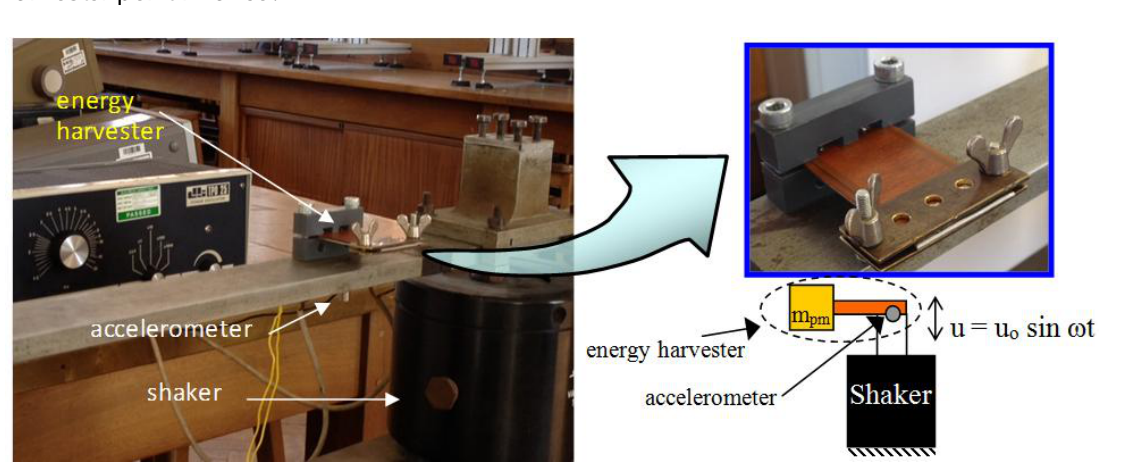
Figure 18. Experimental apparatus and a schematic diagram for testing the energy harvester